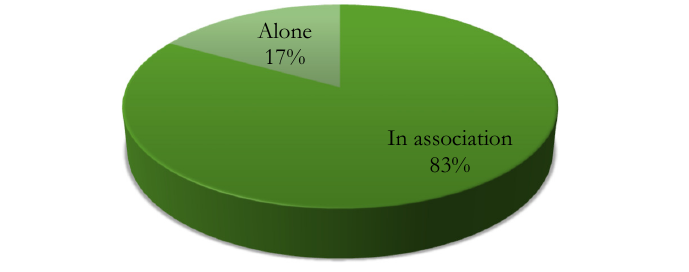
Figure 2. Consumption of plants in association or without allopathic treatment